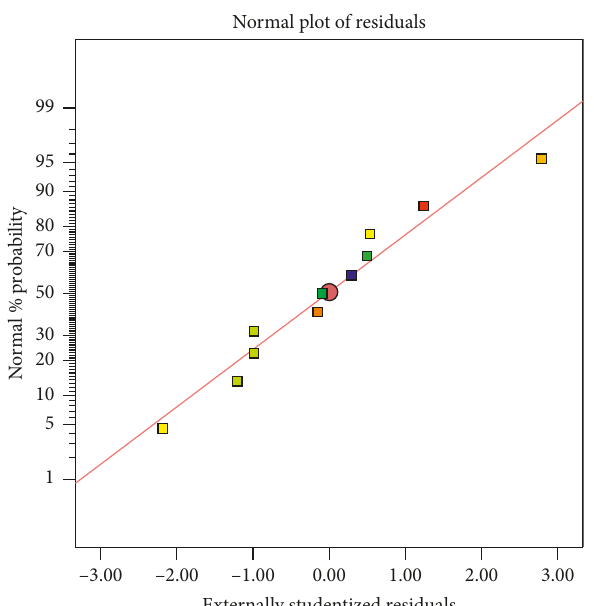
Figure 4: Correlation of calculated turmeric leaves with experi- mentally extracted turmeric leaves.